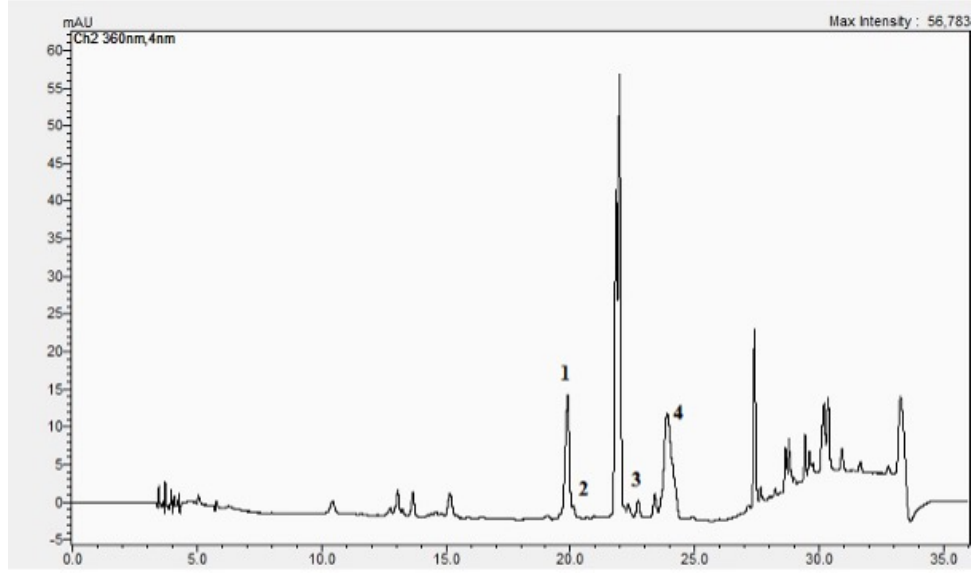
Table 2. BC-GTE fl avonoid content and antioxidant activity.